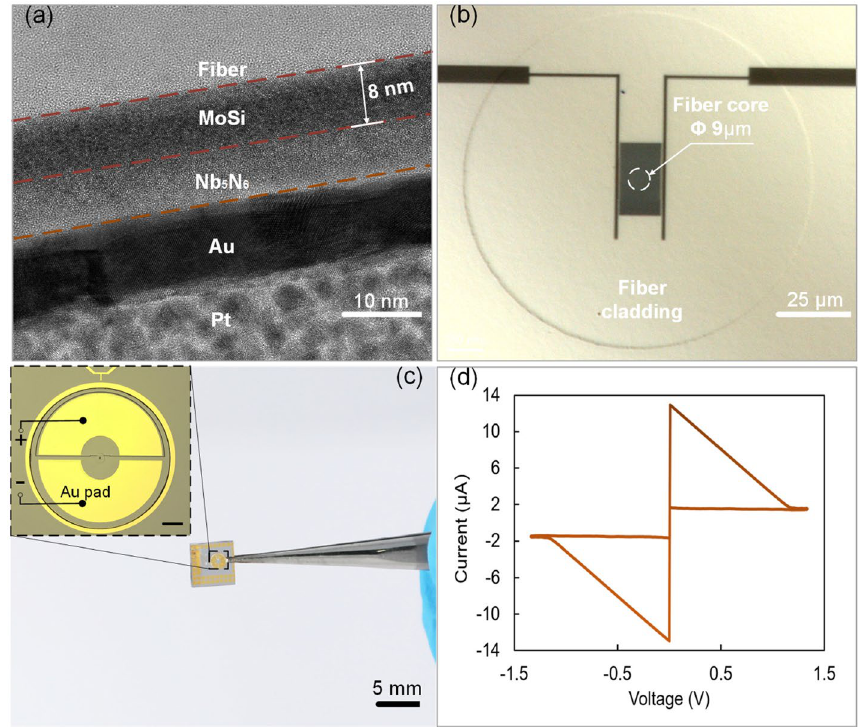
Fig. 3 a TEM of the MoSi film and Nb 5 N 6 film on the fiber tip. b Optical microscope image of the core on the fiber. c Photograph of an FSPD. Inset: optical microscope image of FSPD. Scale bar: 250 μm. d IV trace curve